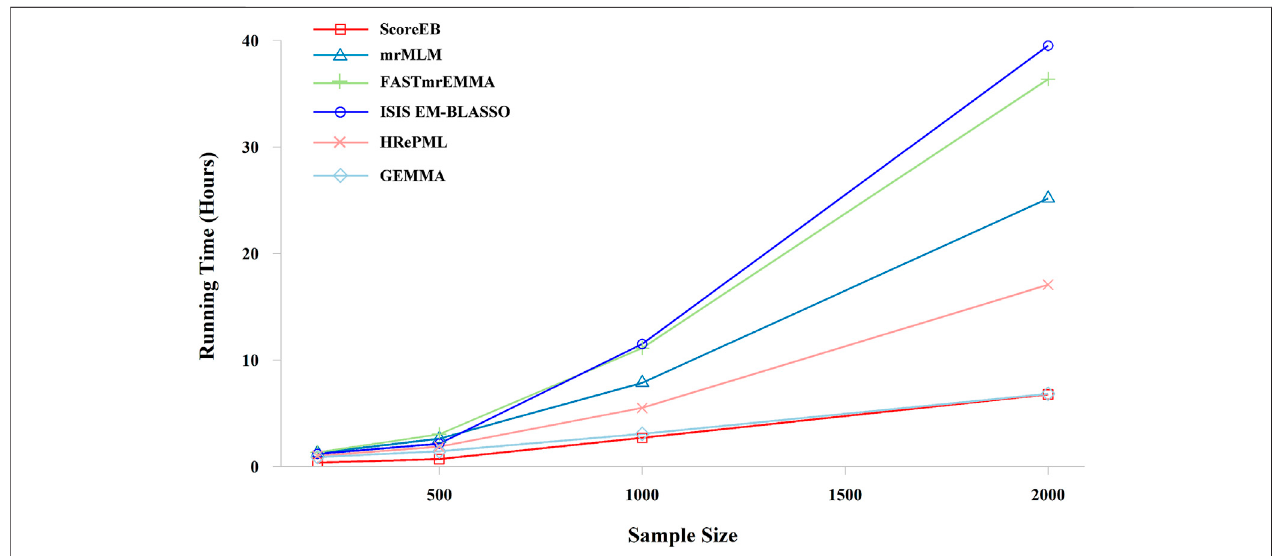
FIGURE 5 | Effect of the sample size on running time with six methods (ScoreEB, mrMLM, FASTmrEMMA, ISIS EM-BLASSO, HRePML and GEMMA) in simulation 3.